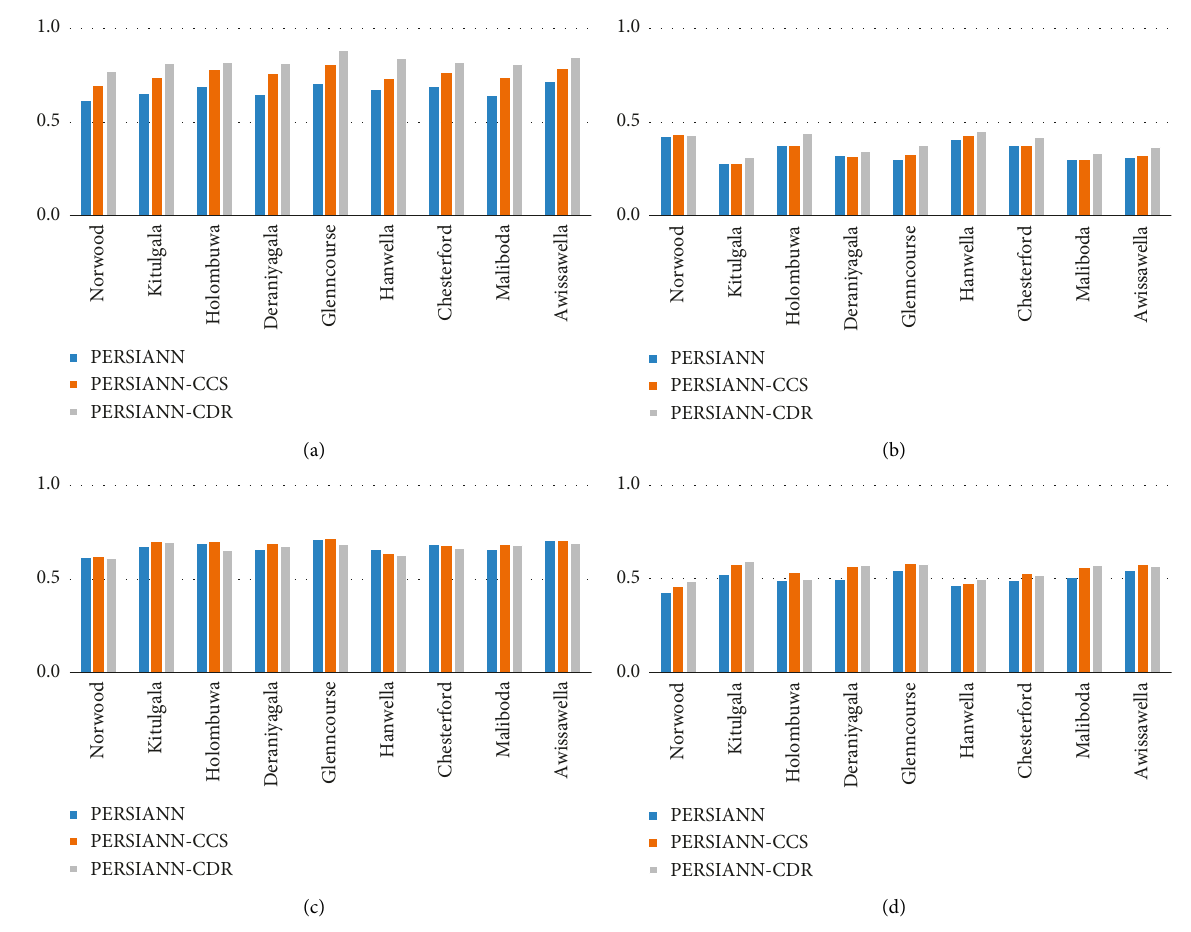
Figure 5: Results of categorical indices. (a) For POD values. (b) For FAR values. (c) For PC values. (d) For CSI